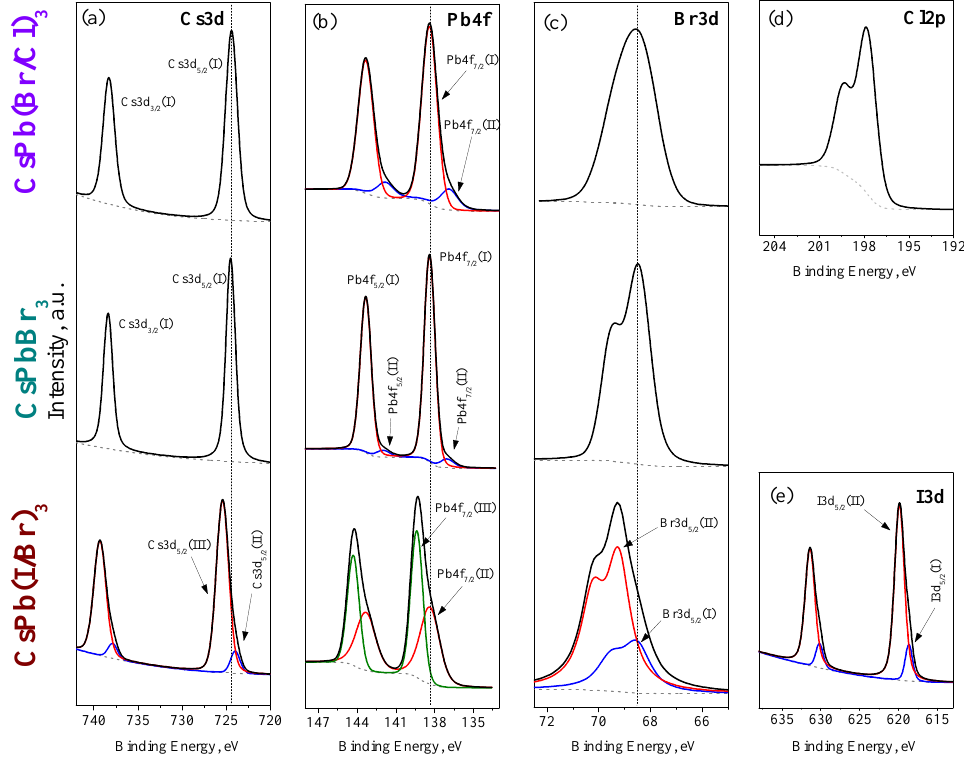
Figure 6. XP spectra of PNCs on the Cs3d ( a ), Pb4f ( b ), Br3d ( c ), Cl2p ( d ) and I3d ( e ) regions. The Cs3d doublet in CsPbBr 3 has a single charge state (Cs3d 5/2 ( I ) , 724.4 eV) relates to Cs + ions in the perovskite lattice. Lead in CsPbBr 3 PNCs exhibits two charge states, one of which, with a higher intensity (Pb4f 7/2 ( I ) , 138.4 eV), refers to Pb 2+ ions in the perovskite lattice and the state with a lower intensity (Pb4f 7/2 ( II ) , 136.9 eV) can presumably be attributed to metallic lead. The intensity ratio of states (I) and (II) is approximately 8.6:1. Traces of metallic Pb in perovskites founded by XPS was noted in previous works and is probably a consequence of the insignificant photolysis of nanocrystals during the analysis [65]. Bromine in CsPbBr 3 is represented by a Br3d doublet (spin orbital splitting 1.0 eV) with a single charge state (Br3d 5/2 (I), 68.5 eV), which relates to bromine ions in the perovskite lattice. Table 1. Binding energy of electrons on the core levels of atoms in composition of PNCs.